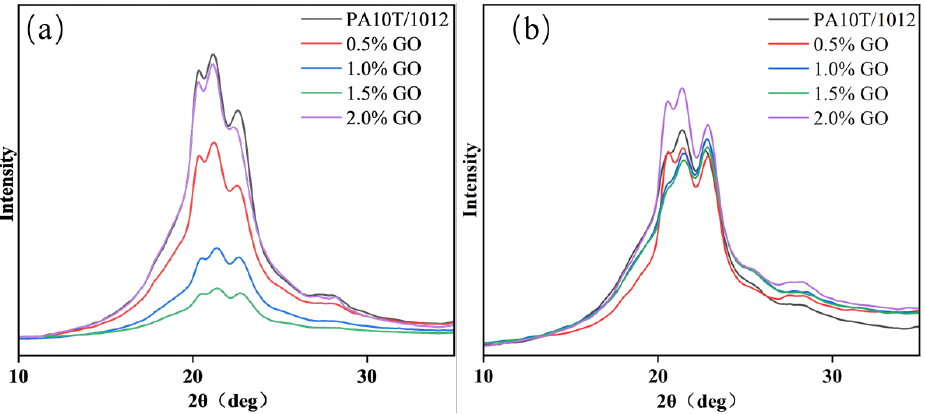
Figure 7. XRD spectra: ( a ) SPA composites; ( b ) MPA composites.